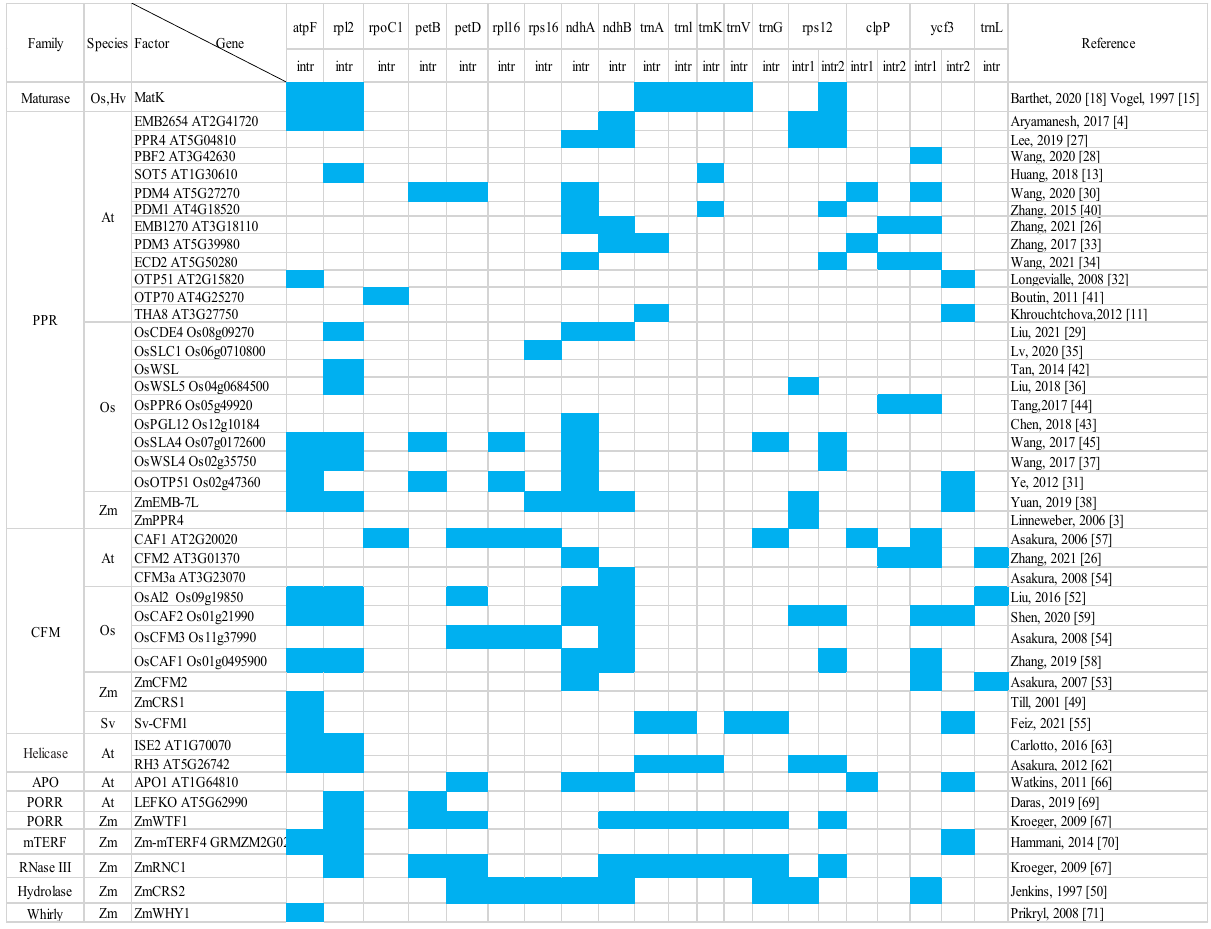
Figure 1. The updated splicing factors involved in chloroplast group II intron splicing. Splicing factors are listed from different protein families that are involved in chloroplast intron splicing and the corresponding references. Blank cells with blue coloring represent the splicing factors that are involved in the splicing of the introns of the indicated pre-mRNA. Os: Oryza sativa L.; Hv: Hordeum vulgare L.; At: Arabidopsis thaliana ; Zm: Zea mays ; Sv: Setaria viridis .